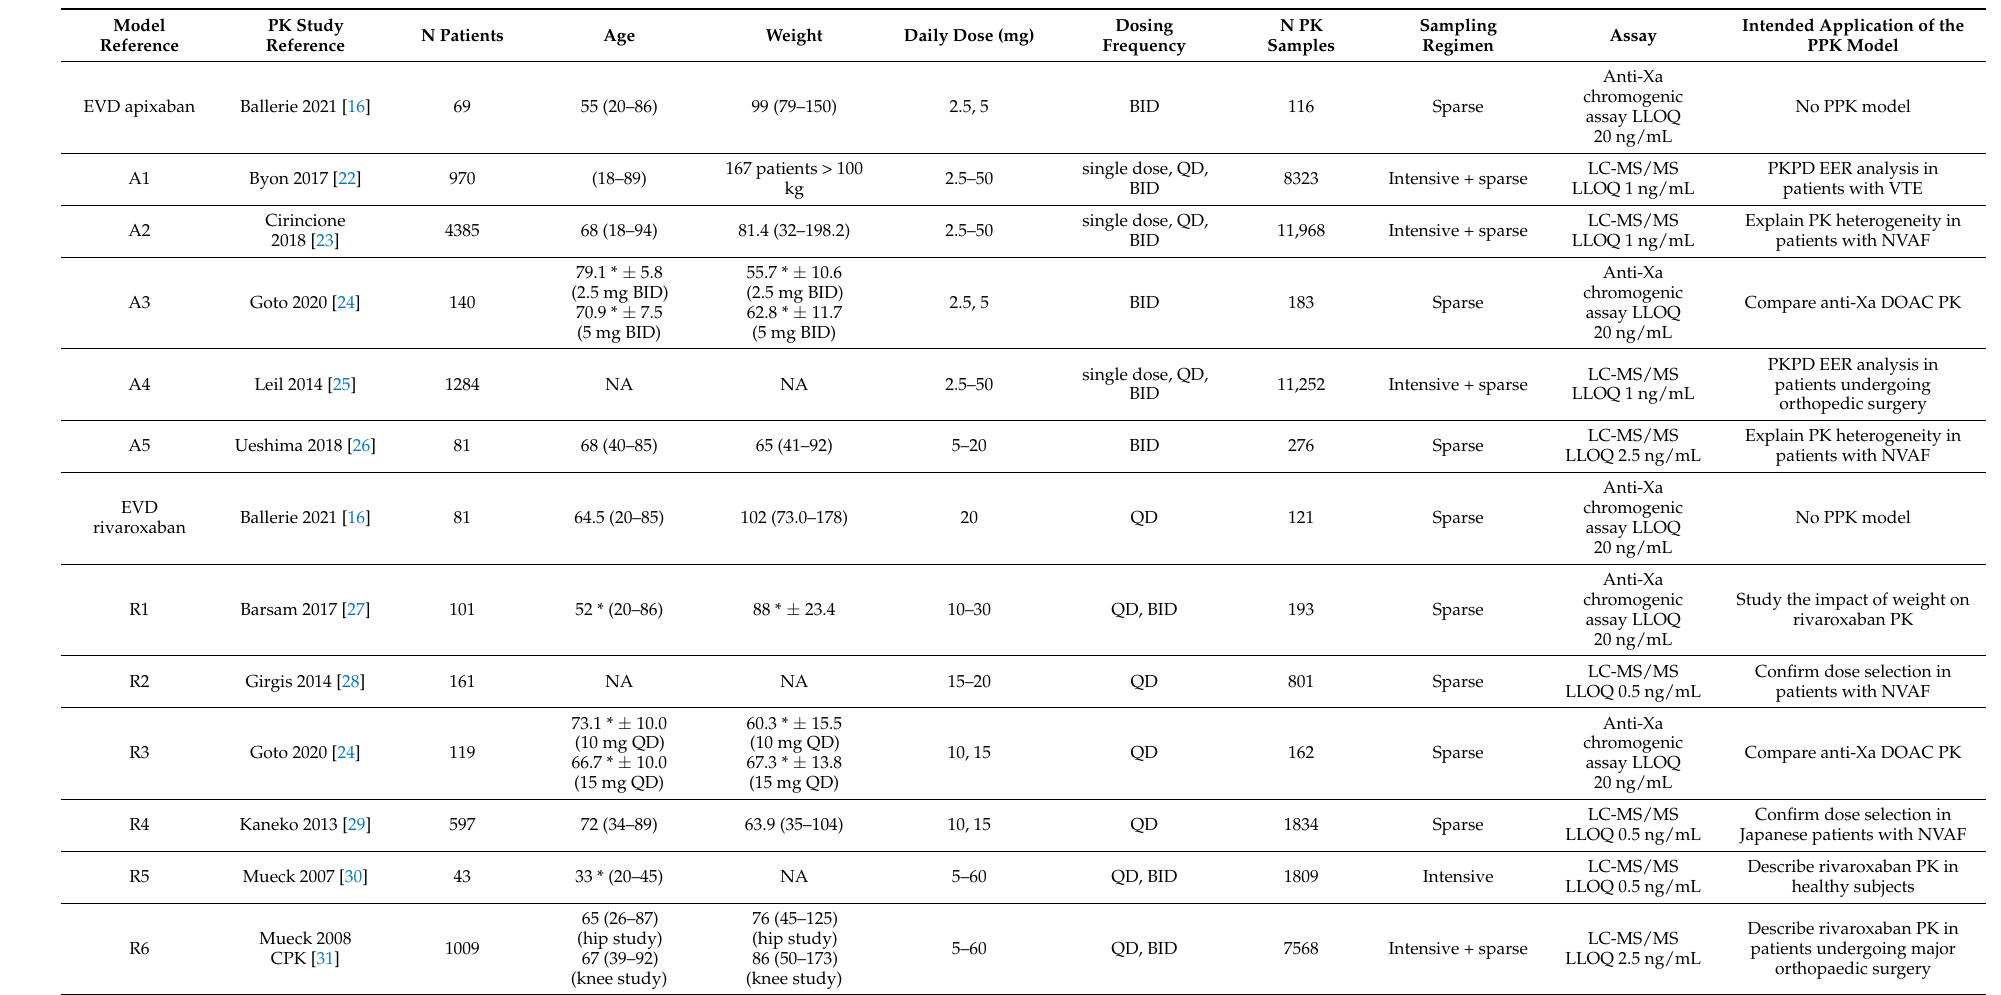
Table 1. Design of the selected population pharmacokinetic